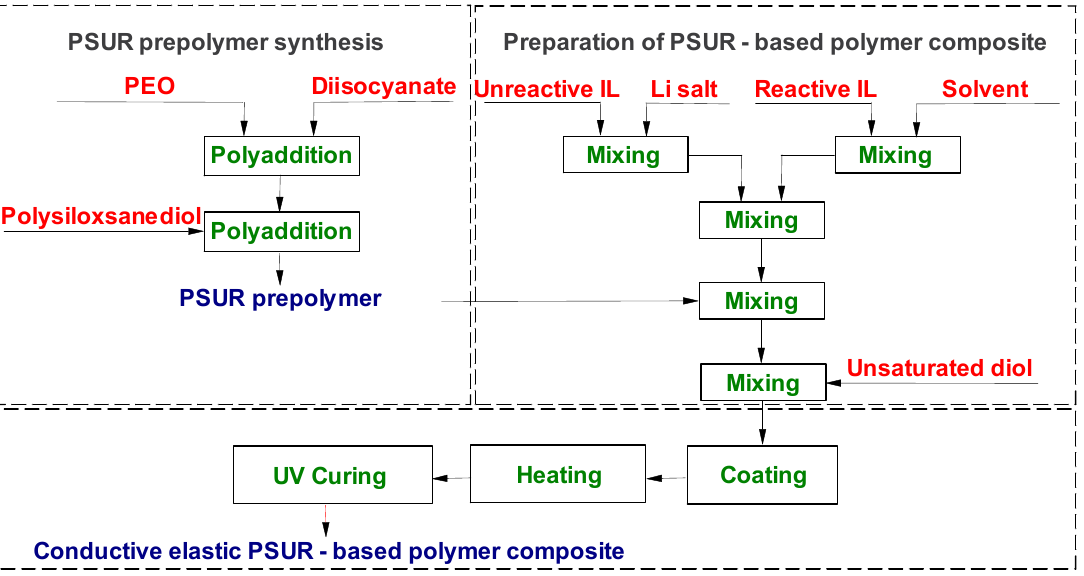
Figure 2. Process of preparation of ILs-containing poly(siloxane-urethane) (PSUR)-based conductive polymer composite.